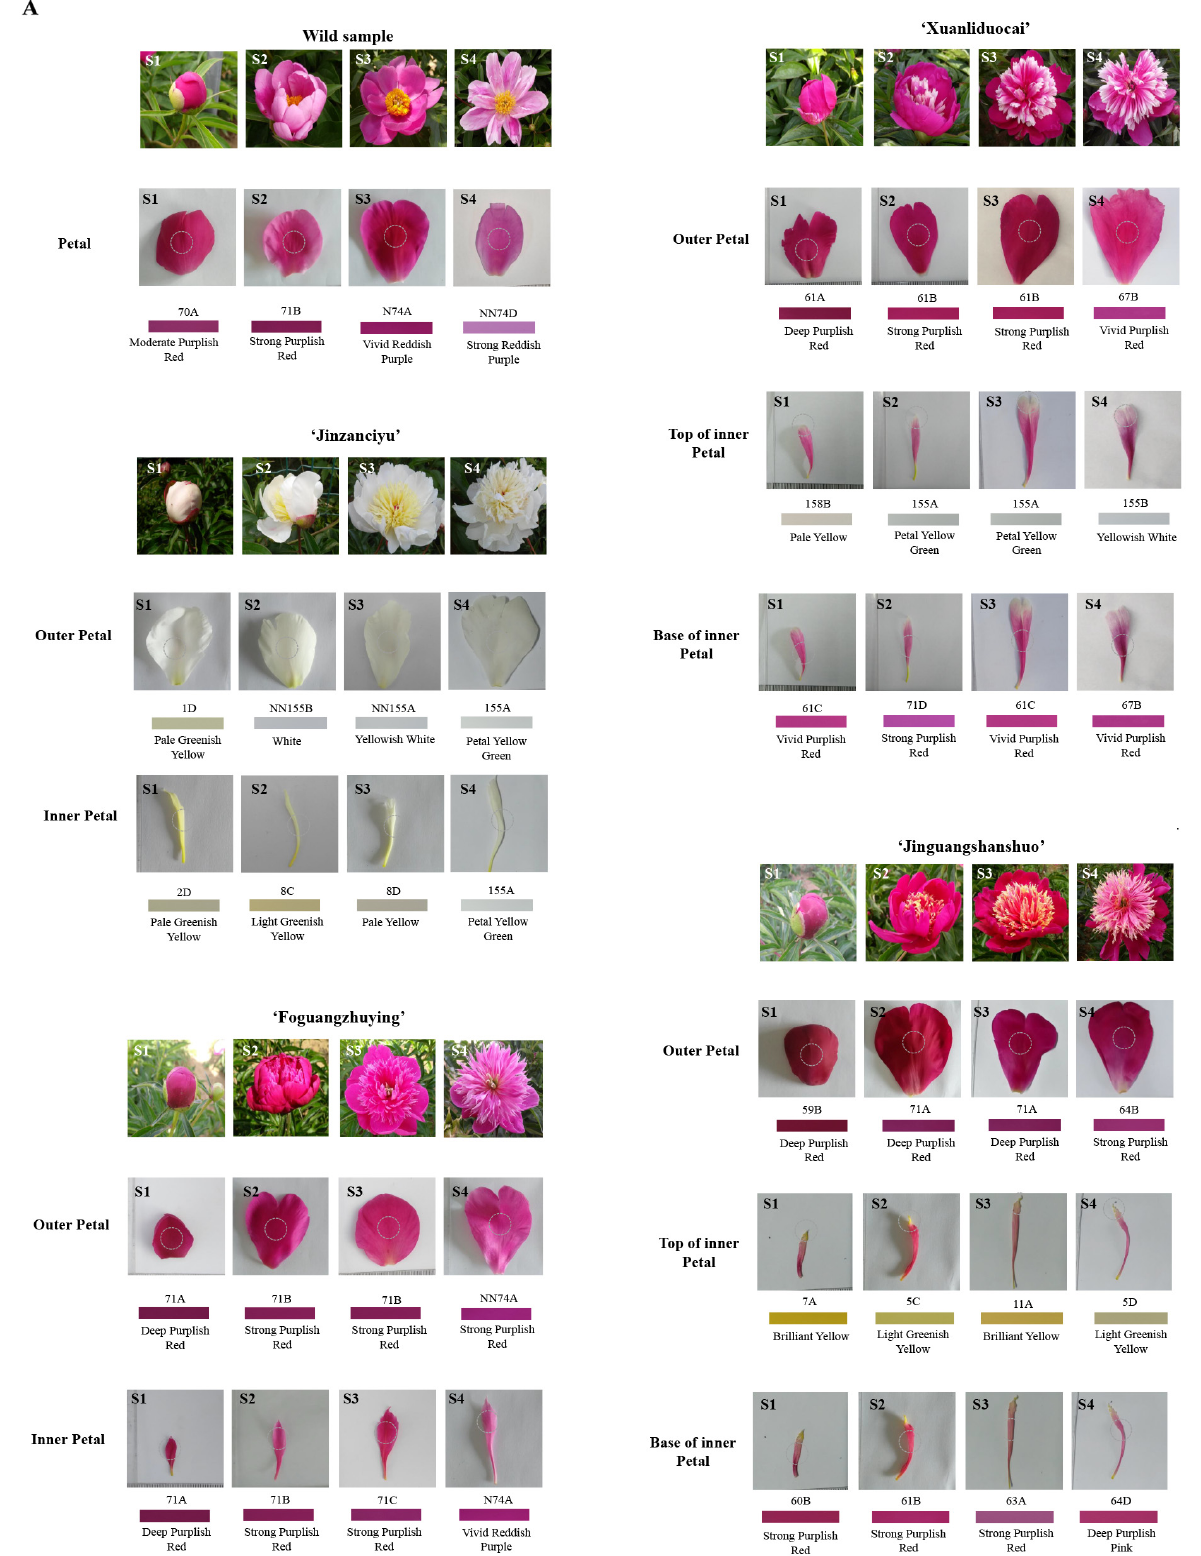
materials were divided into six color systems: white, pinkish-white, yellow, purplish-red, reddish-purple, and crimson.